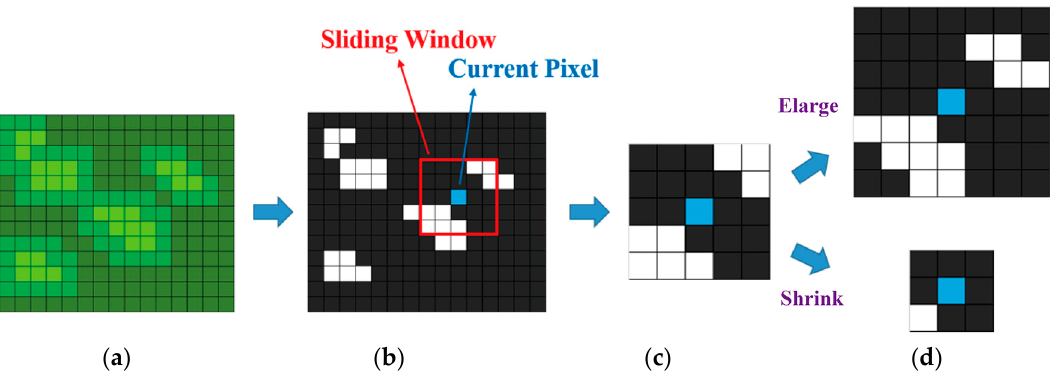
Figure 6. The acquired rate of the sprout in the window from the sprout proportion chart and resizing the window: ( a ) original image; ( b ) preliminarily estimated rate of the sprout; ( c ) calculated rate of the sprout in the sliding window; and, ( d ) changed window size.